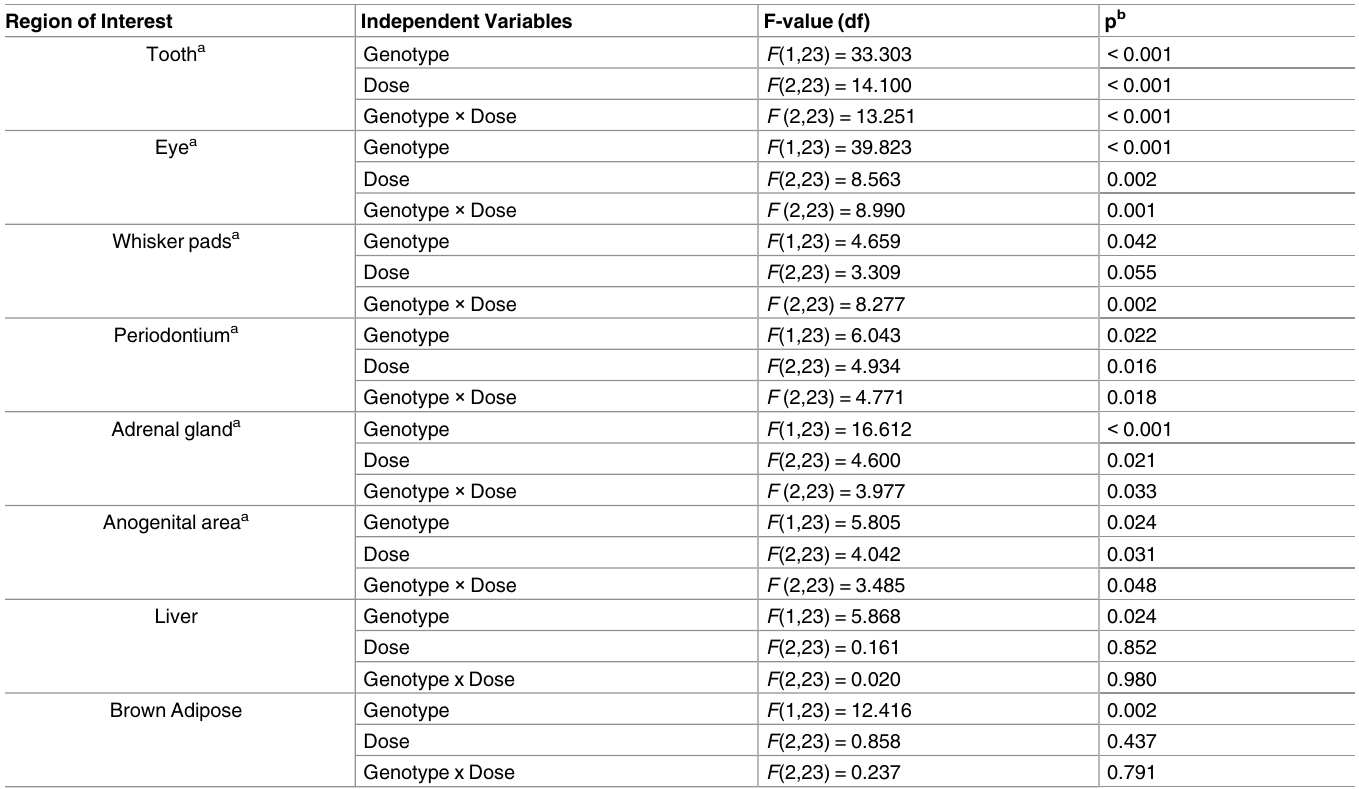
Table 2. Univariate tests